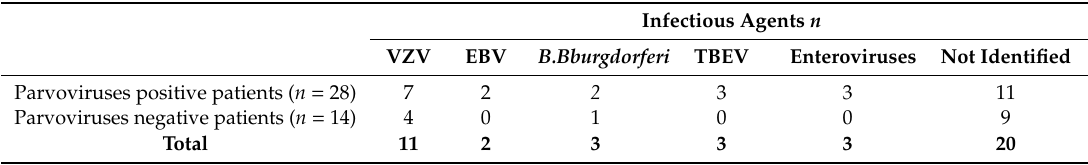
Table 3. The presence of HBoV1–4 and B19V genomic sequences together with markers of other infectious agents among